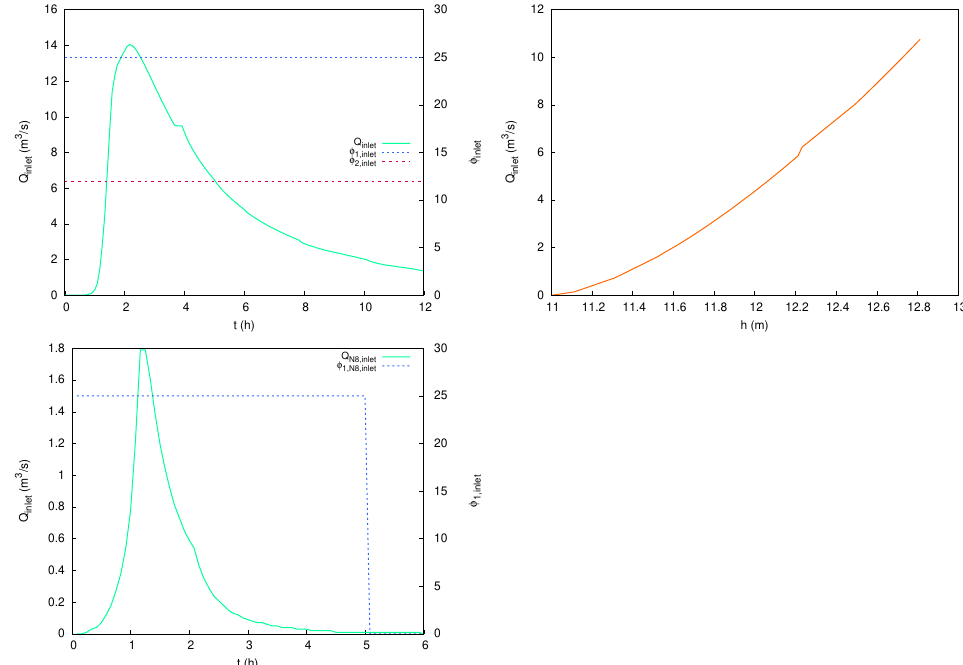
Figure 11. Case 3: Water discharge and concentration for both pollutants at the surface boundary inlet point ( left ). Stage discharge rating curve used for the river connection ( right ). Water discharge and TSS concentration at the sewer node N8 ( lower